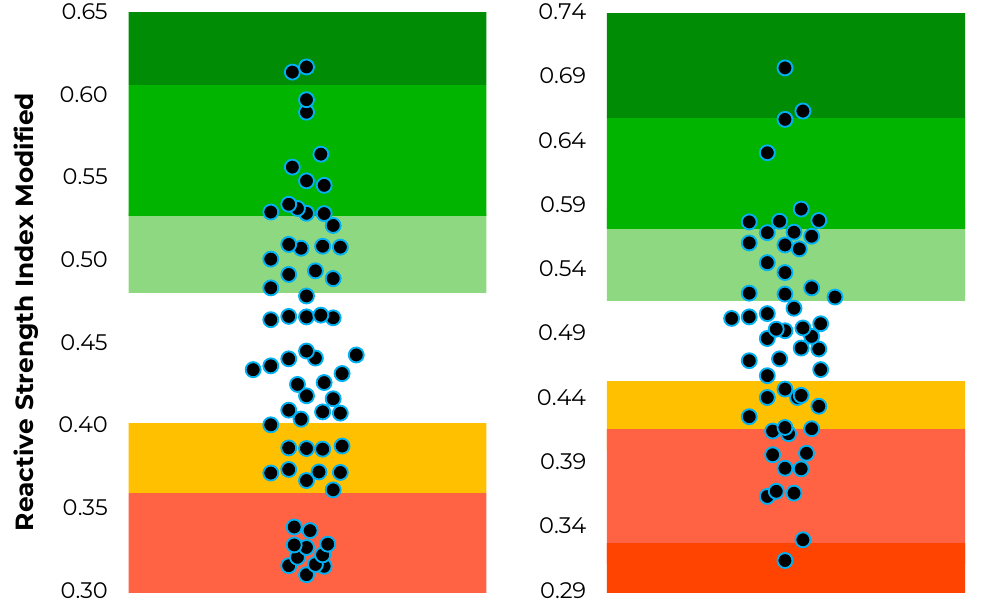
Figure 3. Distribution of modified reactive strength index scores (represented by the individual dots) and corresponding traffic light system based on T-score thresholds for rugby league forwards ( left ) and backs ( right ).